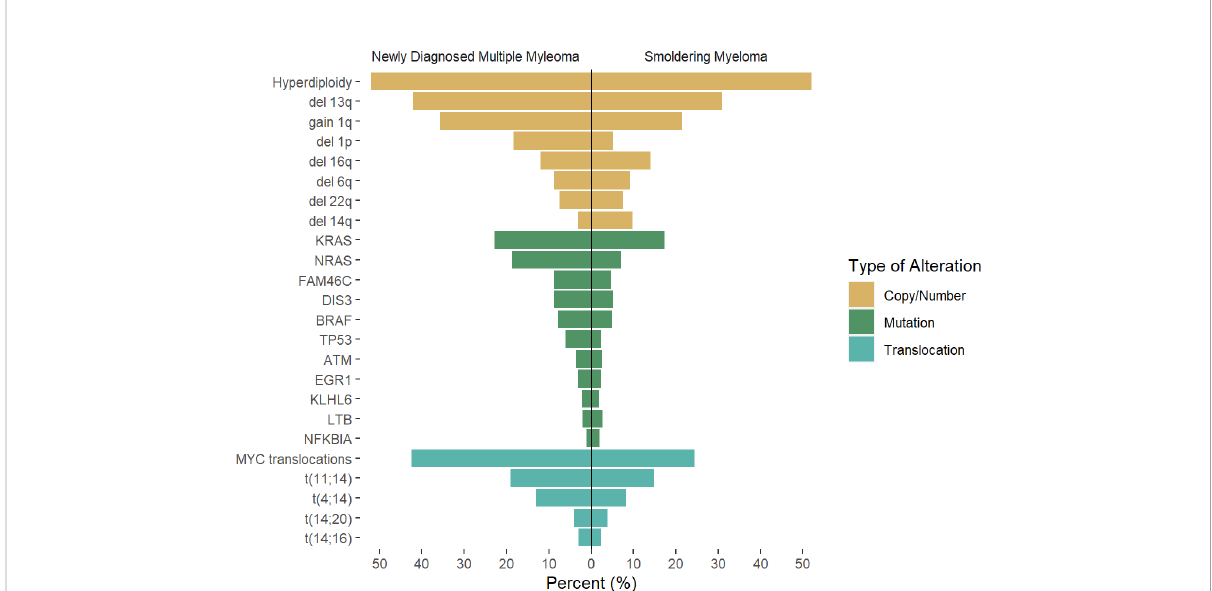
FIGURE 1 Rate of genetic alterations across newly diagnosed multiple myeloma and smoldering myeloma. Results of previous reports by Boyle et al (22), Bustoros et al (17), Misund et al (23), Walker et al (24) were pooled to the described average rate of the described alteration, as there is variability in likely secondary to differences in methodology used. Differences across studies and methodology used may account for